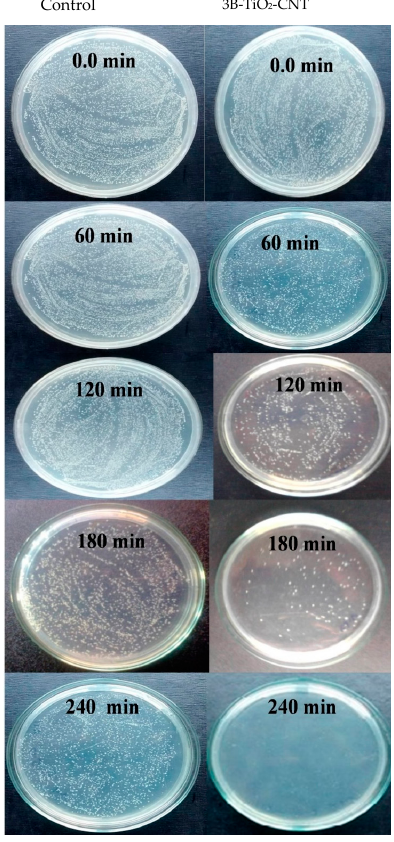
Figure 11. Photographs of photo-inactivation of E. coli under visible light exposure.